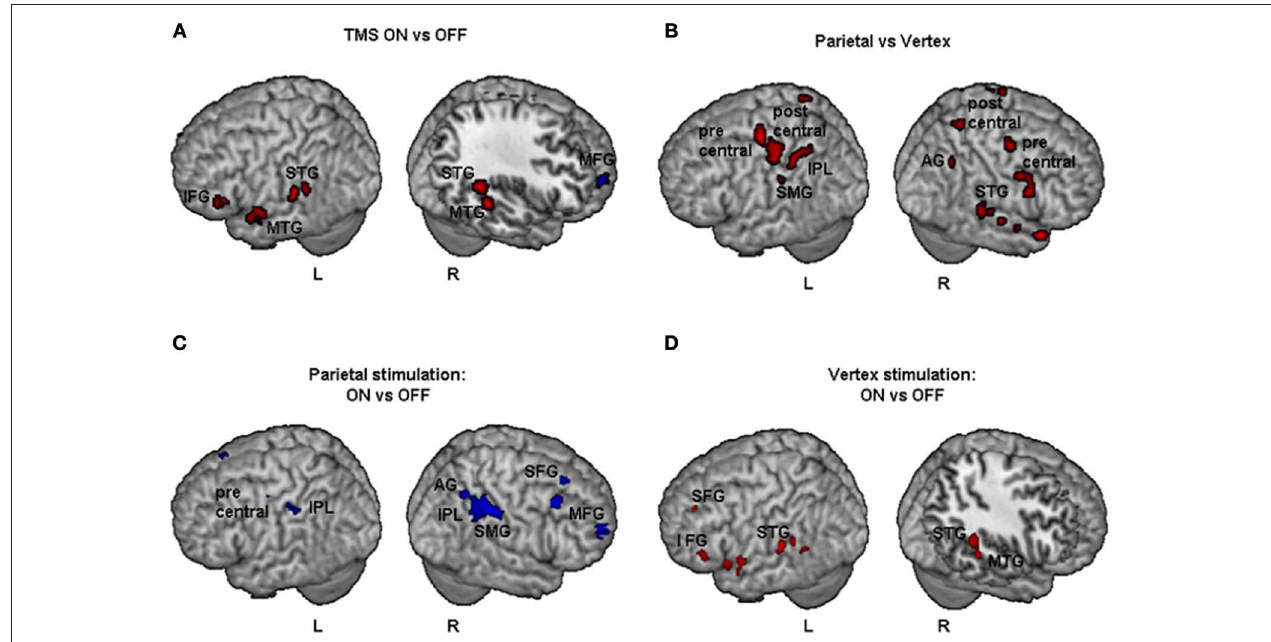
FIGURE 4 | Group fMRI results during task execution for (A) TMS on vs. TMS off (independently of the site of stimulation), (B) parietal vs. vertex stimulation (independently of on off trials), (C) parietal: TMS on vs. TMS off, (D) vertex: TMS on vs. TMS off. Blue and red indicate areas with a significantly ( P < 0 . 001 uncorrected; cluster level